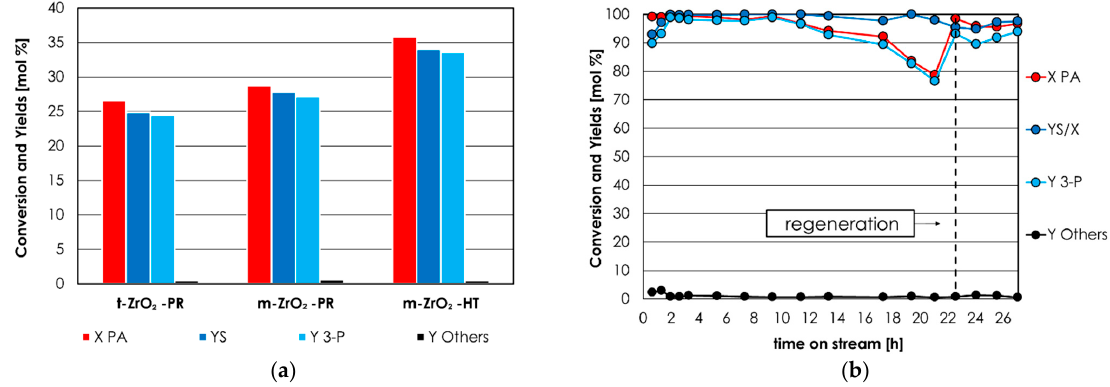
Figure 3. ( a ) Propionic acid ketonization over m- ZrO 2 -HT, m- ZrO 2 -PR, and t- ZrO 2 -PR. Reaction conditions: temperature = 350 °C, PA = 30 mol % in N 2 , time factor = W/F = 0.1 s*g/mL. ( b ) Propionic acid ketonization over m- ZrO 2 -HT as a function of the time-on-stream. Reaction conditions: temperature = 400 °C, molar % of propionic acid = 20% in N 2 , time factor = W/F = 0.1 s*g/mL. Symbols: propionic acid conversion (X PA, red), sum of yields ( a ) or molar balance ( b ) (YS and YS/X, respectively, blue), 3-pentanone yield (Y 3-P, light blue); by-products sum of yields (Y Others, black). The comparison between the activity of m -ZrO 2 and t -ZrO 2 has been reported by